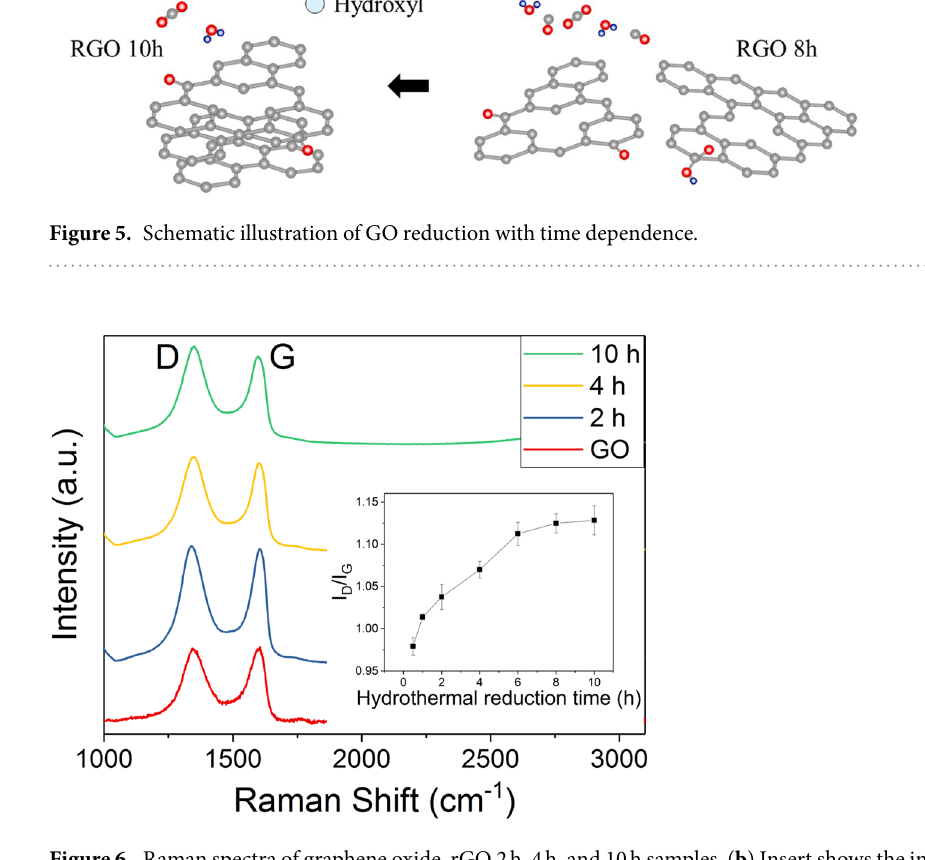
Figure 6. Raman spectra of graphene oxide, rGO 2 h, 4 h, and 10 h samples. ( b ) Insert shows the intensity ratio of D band over G band for GO and rGO treated at different